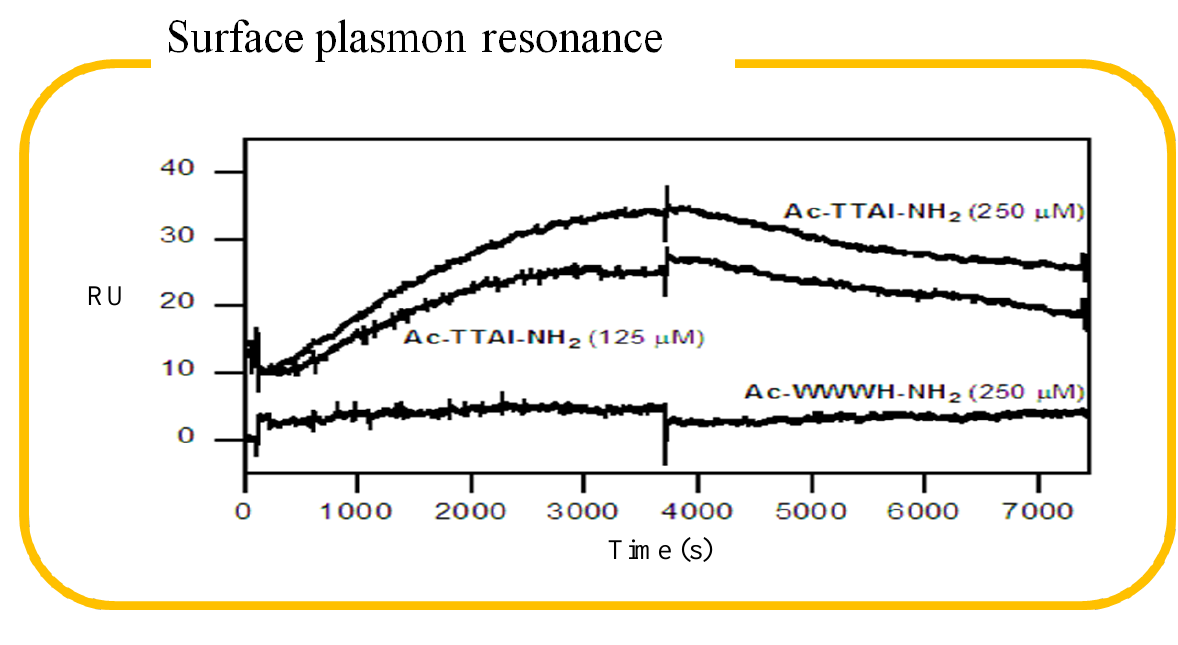
(250 μM) is not recognized 2 were shifted (10 RU) for 2